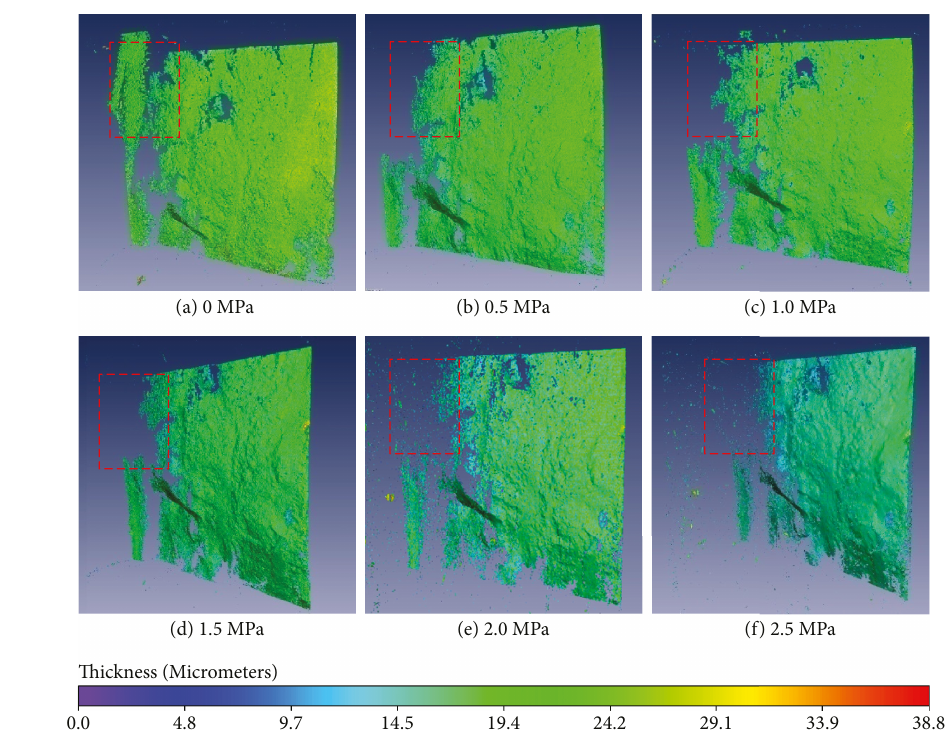
Figure 13: Characteristics of fracture evolution based on CT pseudocolor images.